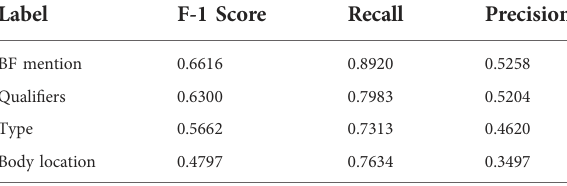
TABLE 6 Entity-based body function evaluation (training).